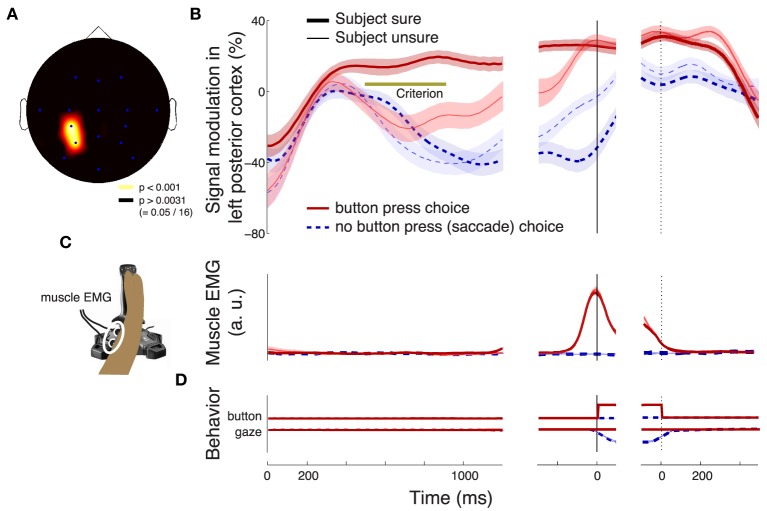
Characterization of the neural effect of the choice confidence. (A) A rendering of the regions that significantly encode the weight associated with the choice confidence in the multiple regression on the alpha-band neural signal, during all button press choices. The neural signal was averaged over the period of significance of the confidence effect (solid bar below the abscissa in Figure 3C). Regions surrounding channels with significant confidence weights (Bonferroni-corrected, p < 0.05∕16) are visualized in hot colors (see inset). The effect is predominantly observed at left posterior channels P3 and CP3. (B) Mean ± SEM alpha desynchronization in left posterior regions (averaged over channels P3 and CP3), as a function of time. Data are shown separately for sure (thick) and unsure (thin) choices, and for button press (red) and saccade choices (blue). The yellow horizontal line labeled with “Criterion” illustrates the signal threshold used to predict the confidence level in Figure 8. (C) Mean ± SEM EMG activity of the flexor carpi radialis muscle of the right hand. (D) Mean ± SEM button press and eye gaze signals. In B–D, data are aligned on the onset of the stimulus (left vertical line), the time of movement onset (middle vertical line), and the time of movement cessation (right dotted vertical line). In B and C, the signal power was evaluated in 100 ms windows, overlapping by 1 sample (3.9 ms).